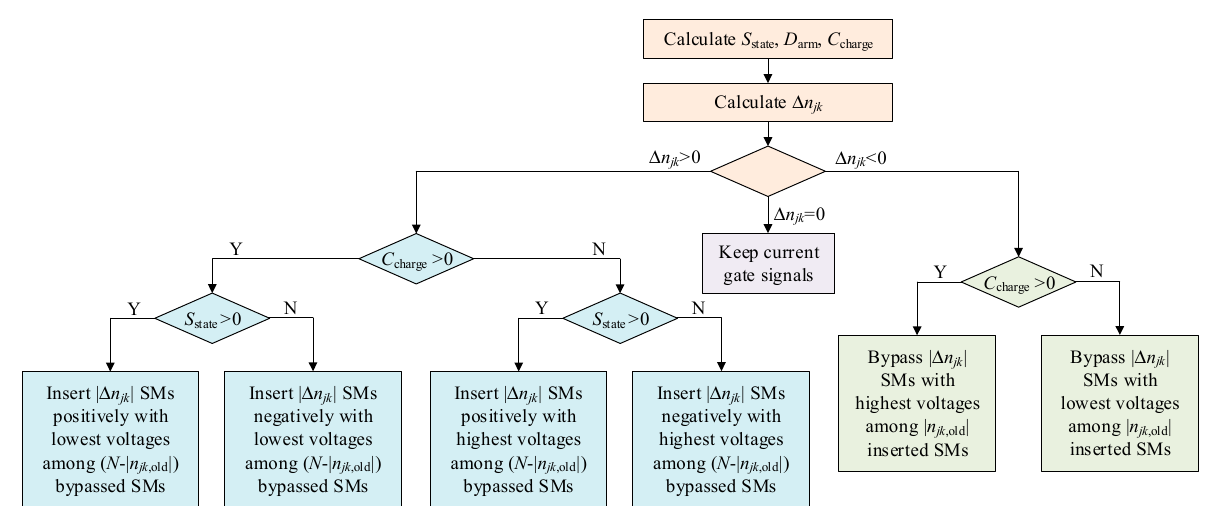
Figure 5. Reduced switching frequency SM voltage balancing method based on state sorting and incremental switching.